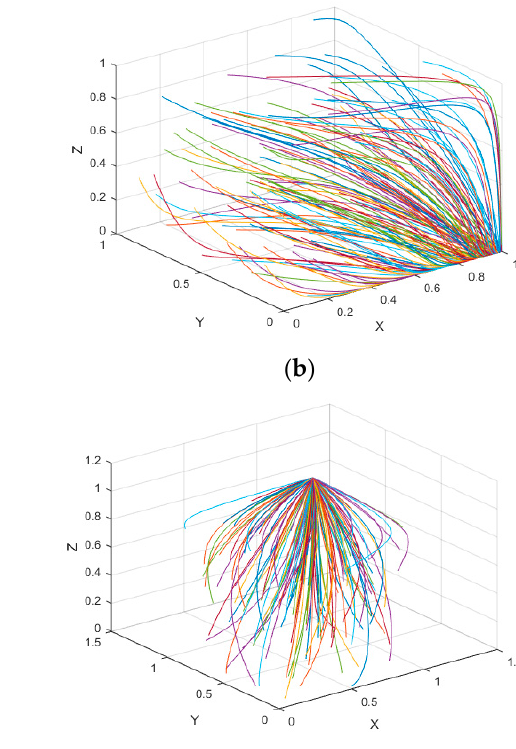
Figure 2. The effects of the initial states on the probabilities of emission reduction activities.